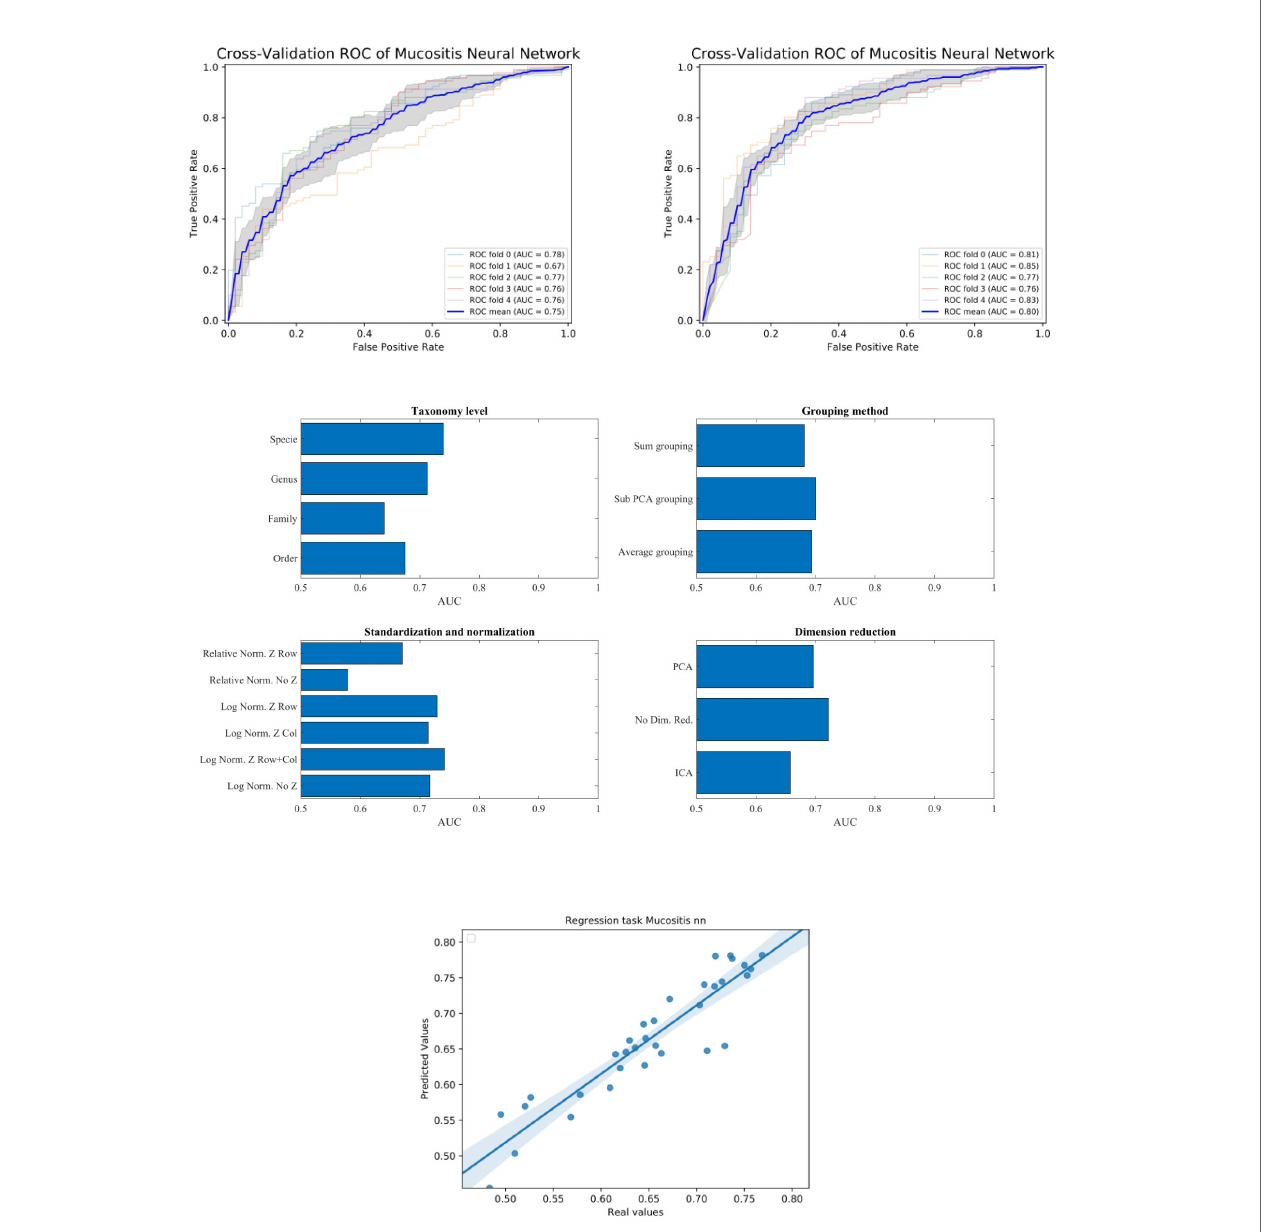
FIGURE 2 | Upper plot typical ROC and the effect of preprocessing. The right plot is using the sub-PCA merging method, while the left plot us using the average merging method. The right upper plot has a higher AUC than the left one. Middle plots - average AUC de fi ned as average AUC using one feature (e.g. one taxonomy level) and all other combinations (e.g. merging methods, normalization etc). Lower plot - Predicted AUC in linear regression vs real linear